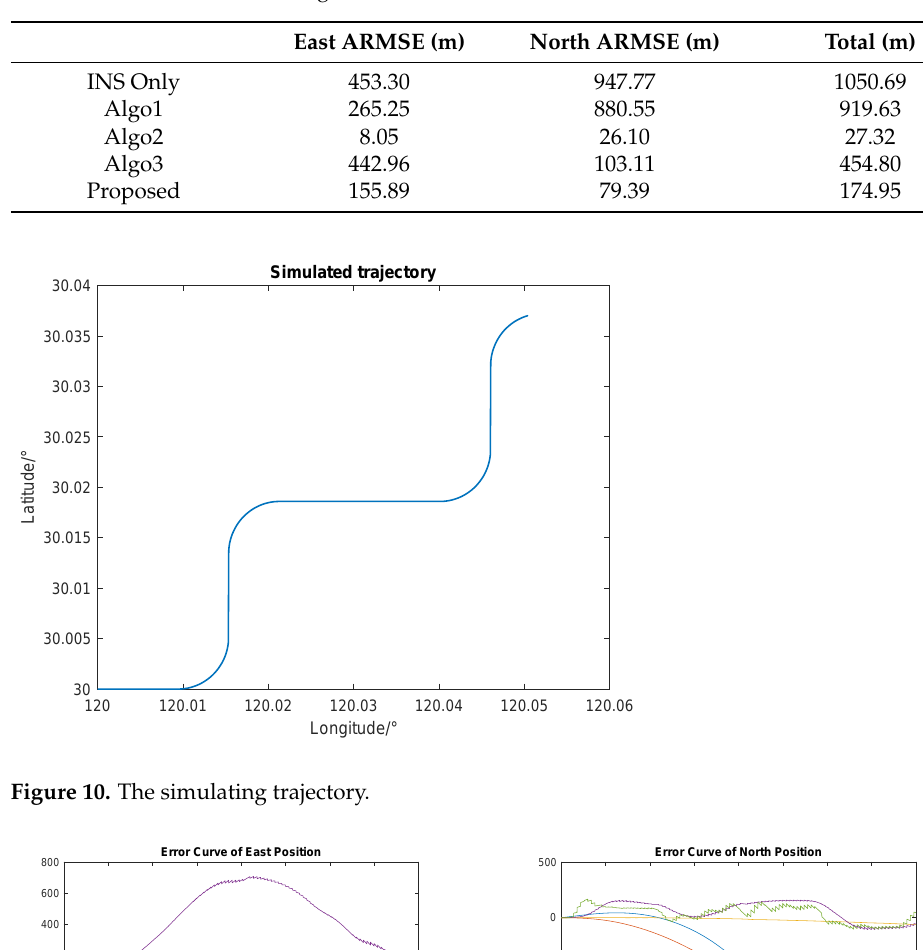
Table 8. The ARMSE of each algorithm.